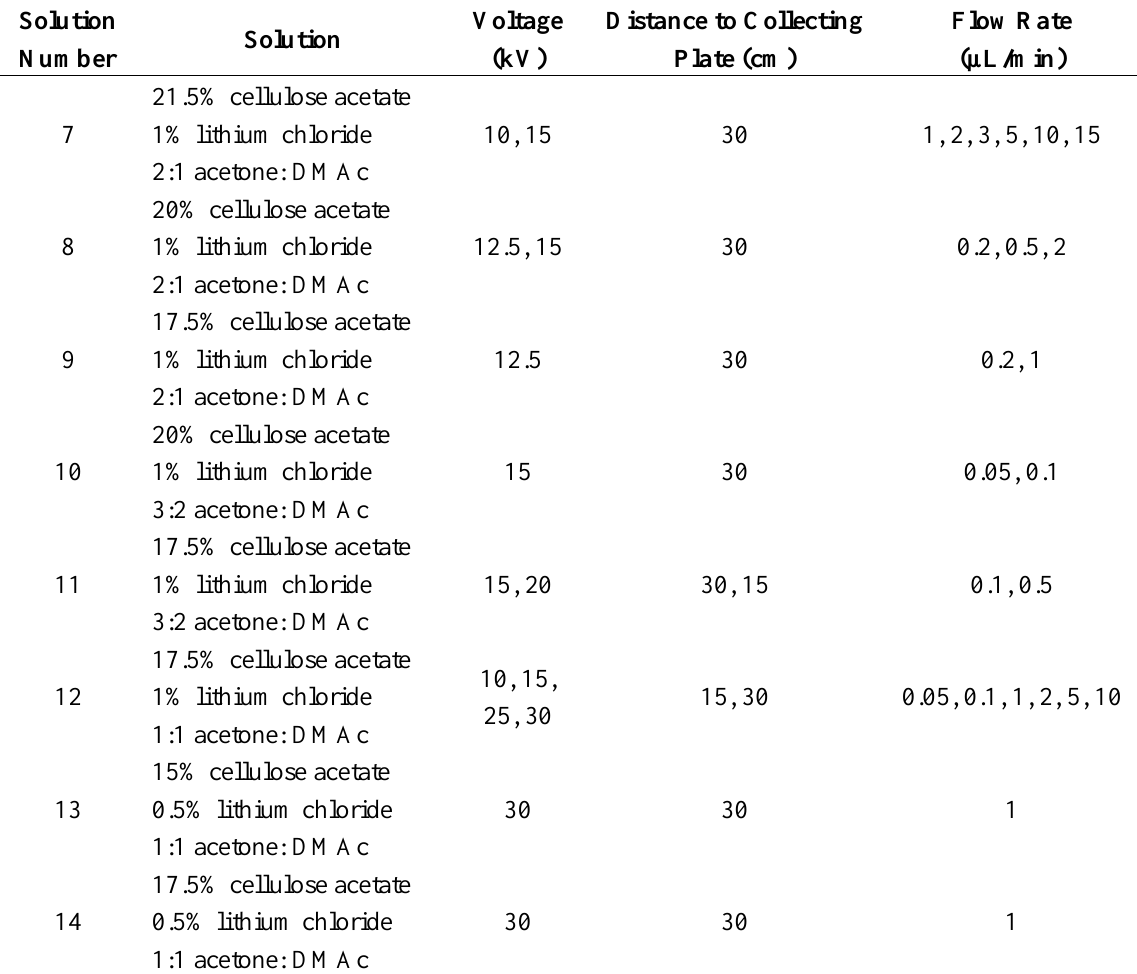
Table 5. Solutions and spinning parameters used to investigate the production of 3D nanofibres.